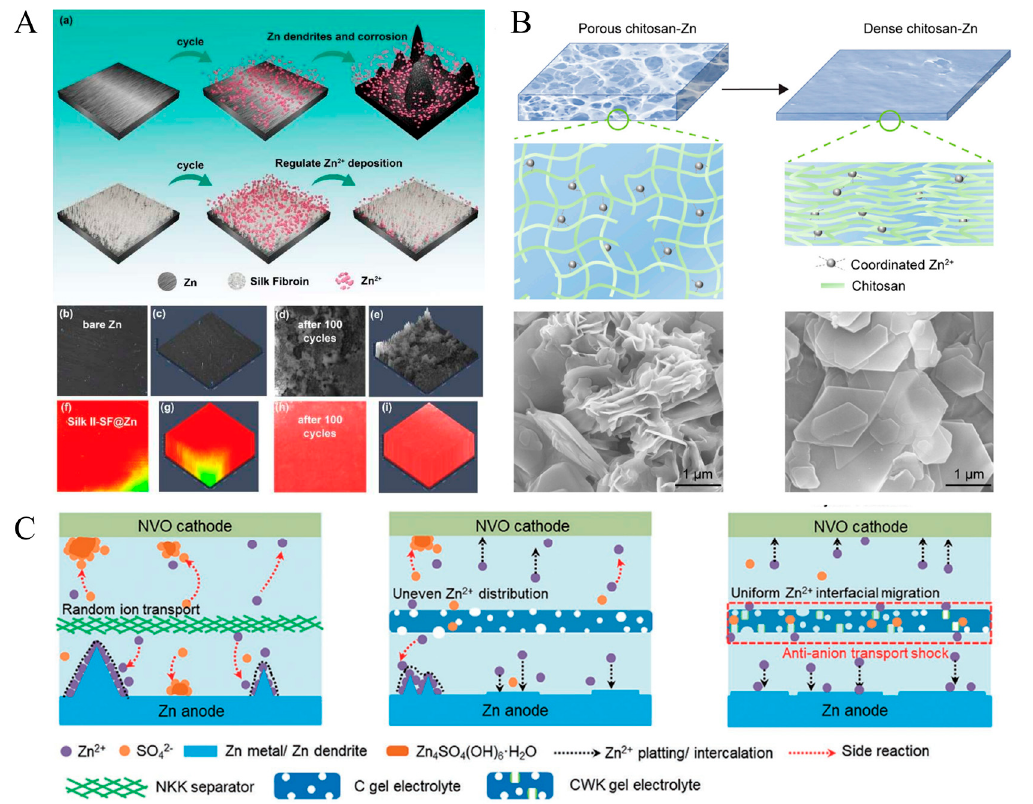
Figure 6. Various biopolymers utilized for fabrication of zinc-based batteries. ( A ) Utilization of silk fibroin as a protective layer for zinc anode to ( a ) prevent dendrite formation as seen by two-photon excitation microscopy of ( b – e ) zinc and ( f – i ) silk coated anode [137]. ( B ) Fabrication of unique and tunable polymer gel electrolyte with chitosan in both ( a ) porous and dense form with respective ( b , c ) SEM images to limit dendrite formation [138]. ( C ) Incorporation of recycled keratin for electrolyte gel that induces porosity in battery cells to facilitate better ion transport and distribute potential dendrite growth [95]. Reproduced with permissions (( A ). Copyright 2022 John Wiley and Sons; ( B ). Copyright 2022 Elsevier; ( C ). Copyright 2022 John Wiley and Sons).